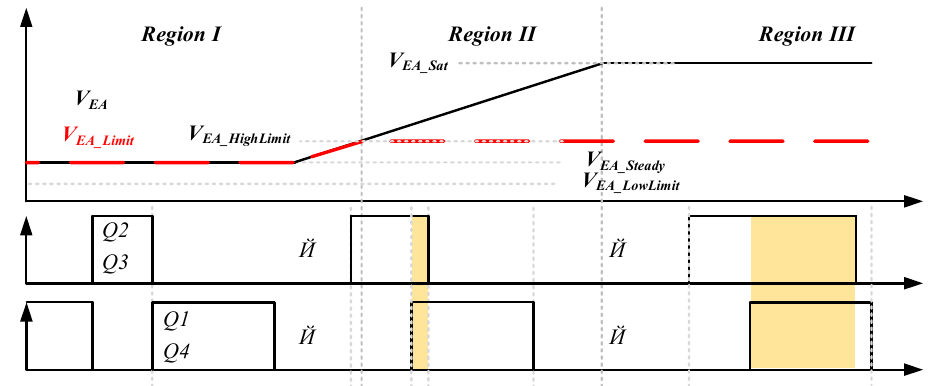
Figure 11. PWM signal of the boundary limit controller in the V EA steady-, transient, and saturation states. Figures 12 and 13 show the simulation results of the complementary and boundary limit controllers for the transient response. The system architecture diagram, circuit parameters, and compensator parameters are shown in Table 1, and Equation (56), respectively. The load resistance switches from R L = 2.5 Meg Ω to R L = 2.5 Ω at t = 70 mS, and switches from R L = 2.5 Ω to 2.5 Meg Ω again at t = 120 mS. Figures 12 and 13 show that both control methods can achieve the effect of eliminating current ripples in the steady-state. Regarding the performance of the overshoot and undershoot of the output voltage, the boundary limit control method was superior to the complementary control method. Using the boundary limit control method to replace the complementary control method, the overshoot performance of the output voltage decreased from 417 mV to 361 mV, and the undershoot performance decreased from 370 mV to 324 mV.